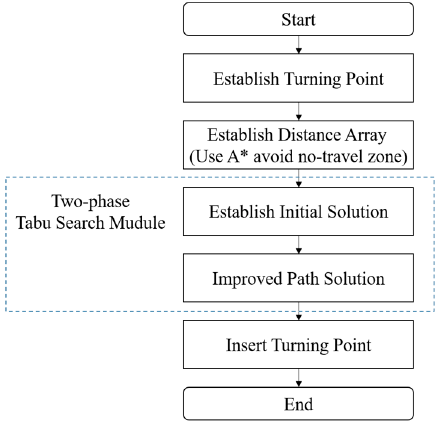
Figure 8. Main flow chart. Figure 8. Main flow